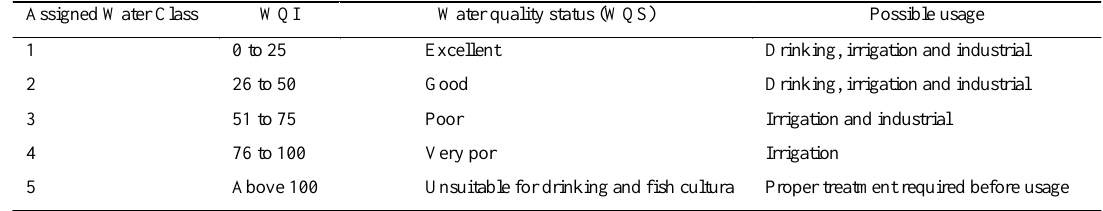
Table 1: WQI ranges and corresponding water quality status and possible usage (Brown et al. ,